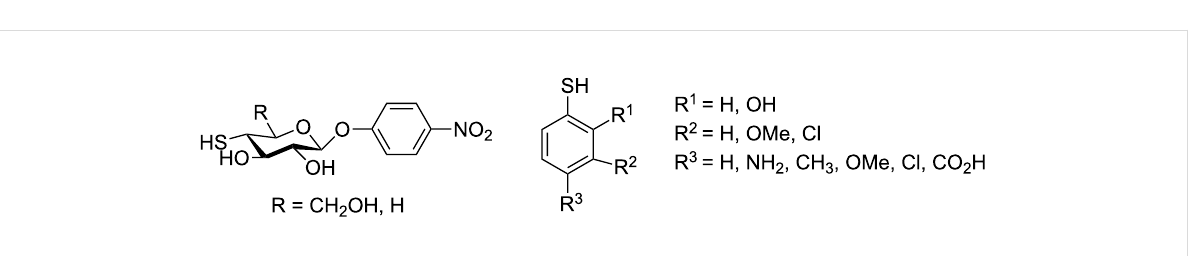
Figure 8: Examples of thiol acceptors utilized with GHs.